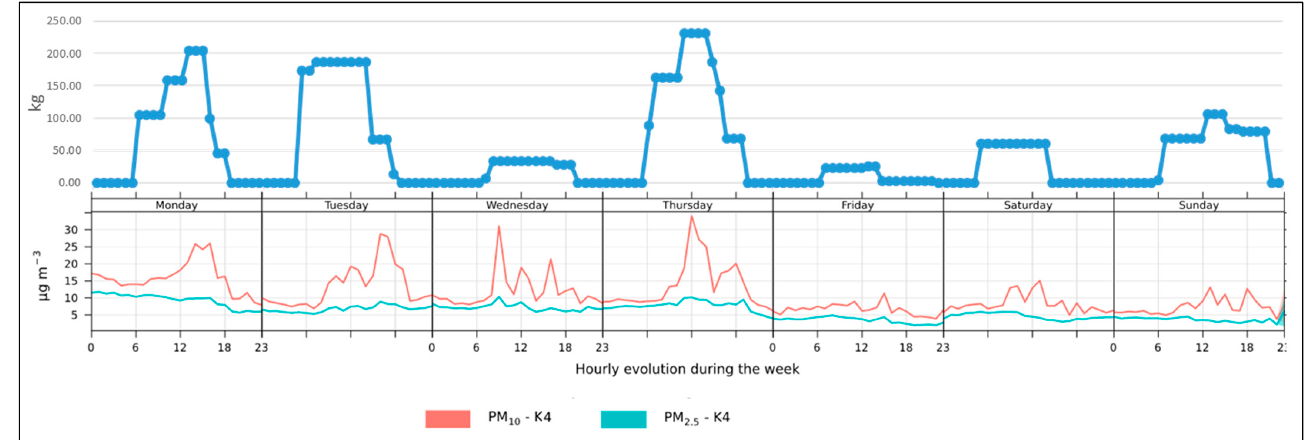
Figure 10. Estimated total cruise ship PM emission (kg) in Kotor Bay vs. PM 10 and PM 2.5 ambient concentrations ( μ m/m 3 ) at K4 measurement location over an observed period from 29 August to 4 September 2022.